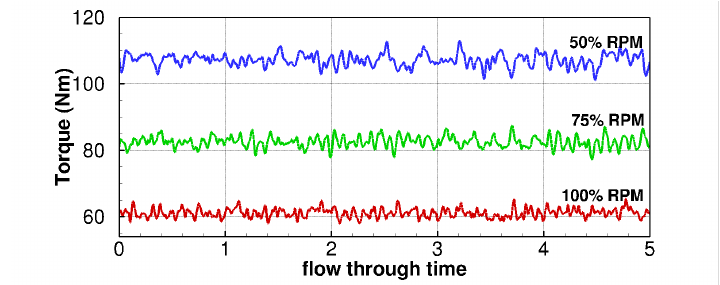
Figure 22. Time histories of torque in the axial direction on the rotor at 50%, 75%, and 100% RPM.